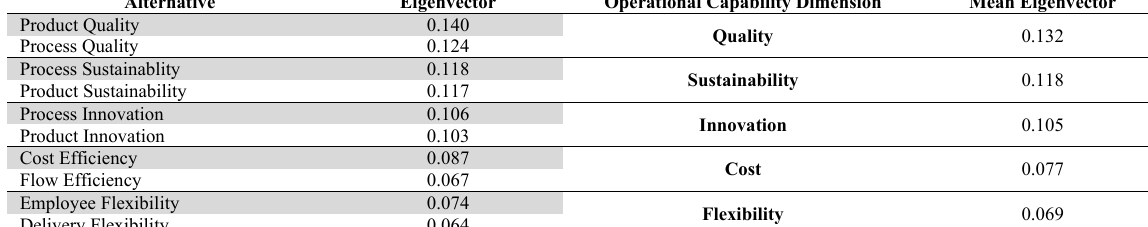
Synthesis of Eigenvector Combination